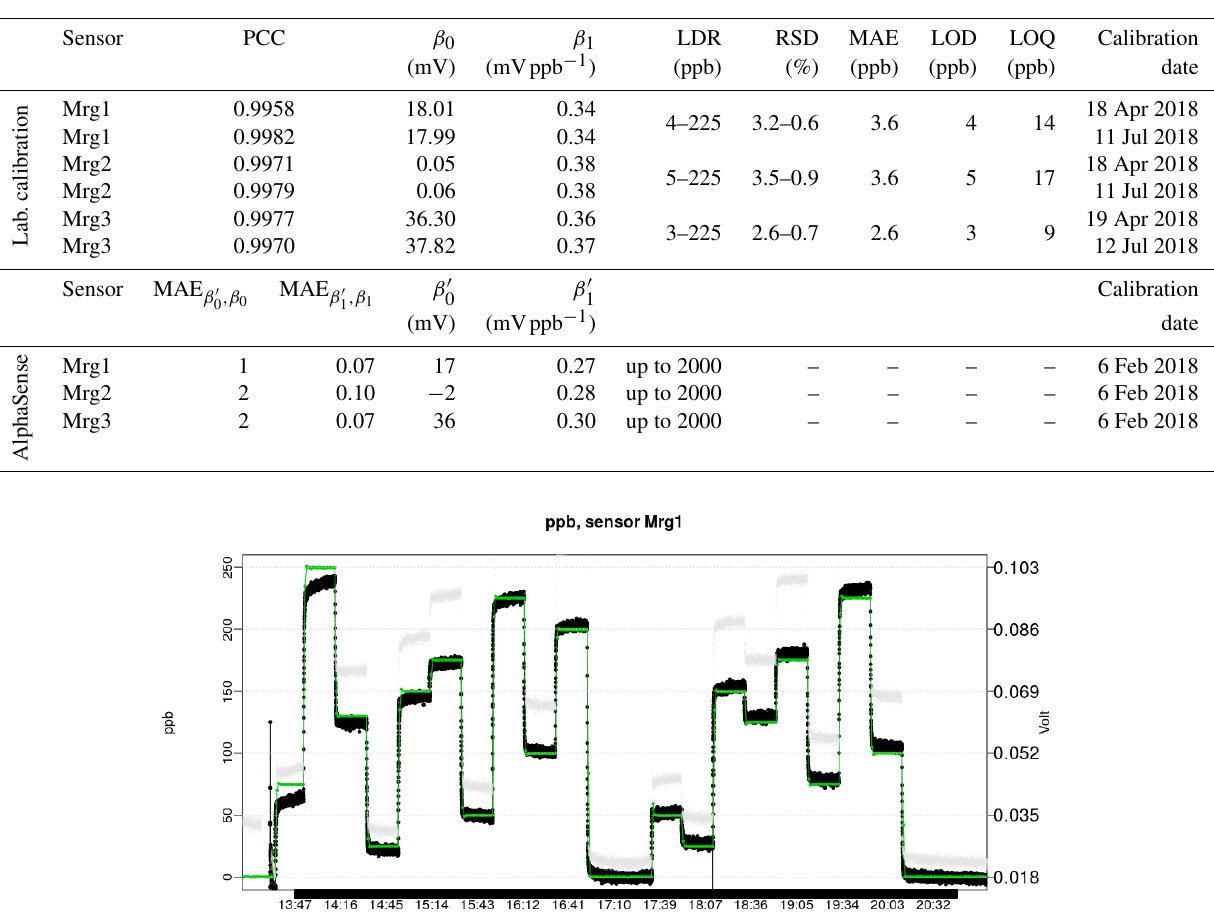
Figure 3. After calibration, voltage data ( V OUT ) of the low-cost sensor is expressed in ppb (black) and compared to the reference ozone concentration (green). The sensor’s ozone concentration, obtained using the intercept, and the regression coefficient, provided by AlphaSense, are also shown (grey). Calibration date is 11 July